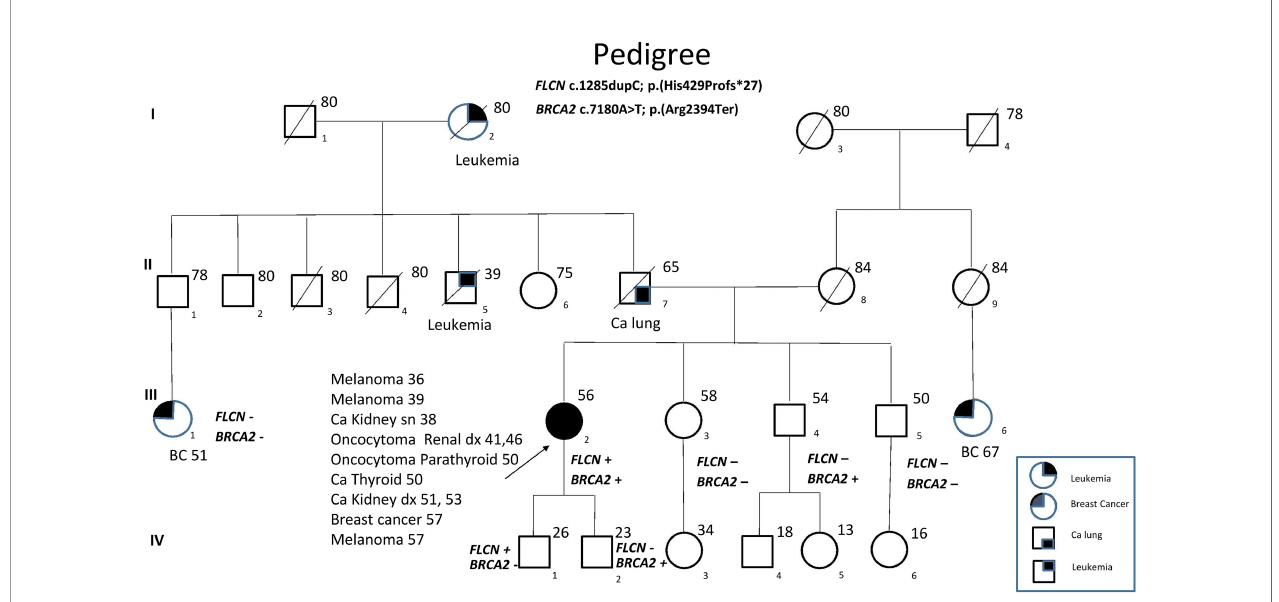
FIGURE 1 | Pedigree of the family with disease-associated FLCN/BRCA2 mutations. Circles represent females, and squares represent males. Symbols with a quarter represent cancer patients. Symbols with a slash indicate deceased individuals. The arrow points to the